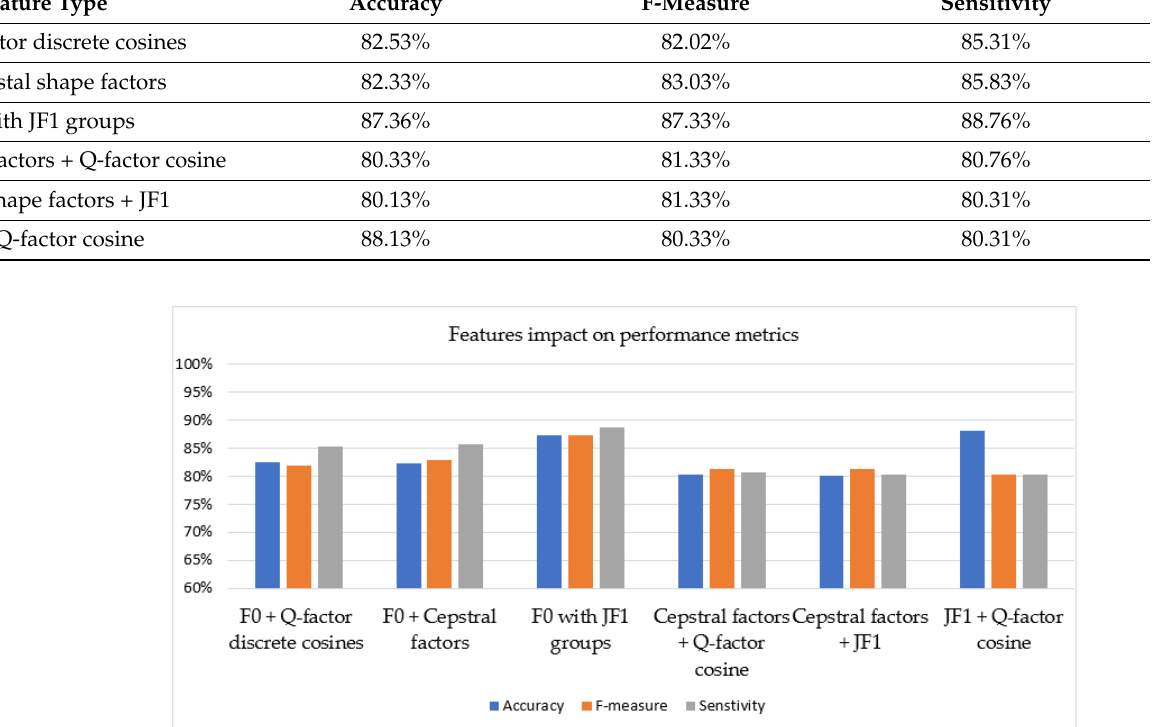
Table 8. Results of double Feature group Joining for DAE Model.